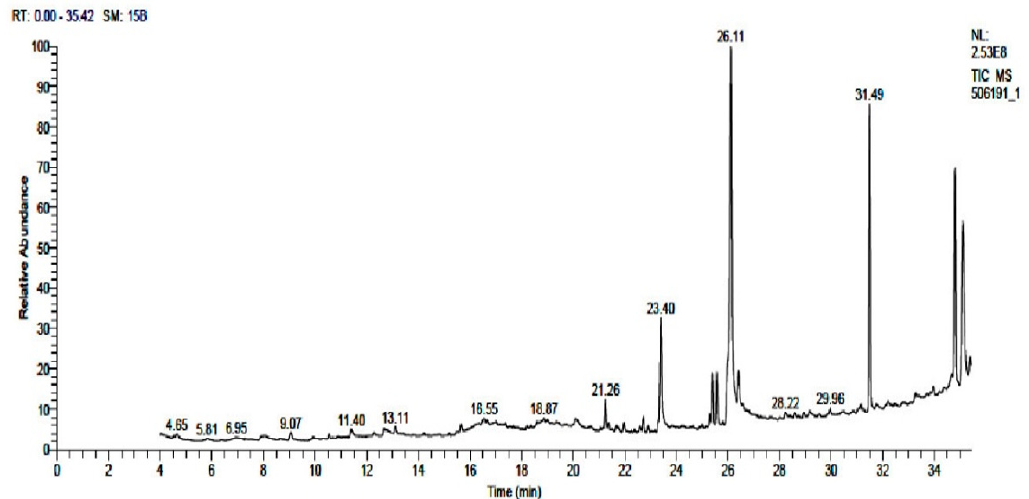
Figure 3. GC–Ms for Taif rose showing peaks with detected compounds.